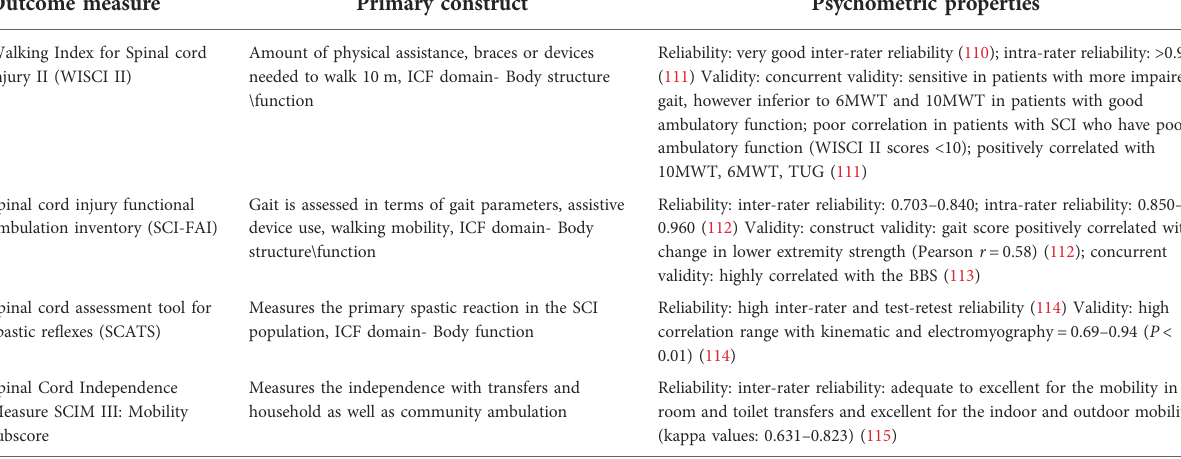
TABLE 2 Clinical measures of lower extremity function and their psychometric properties in individuals with spinal cord injury. Outcome measure Primary construct Psychometric